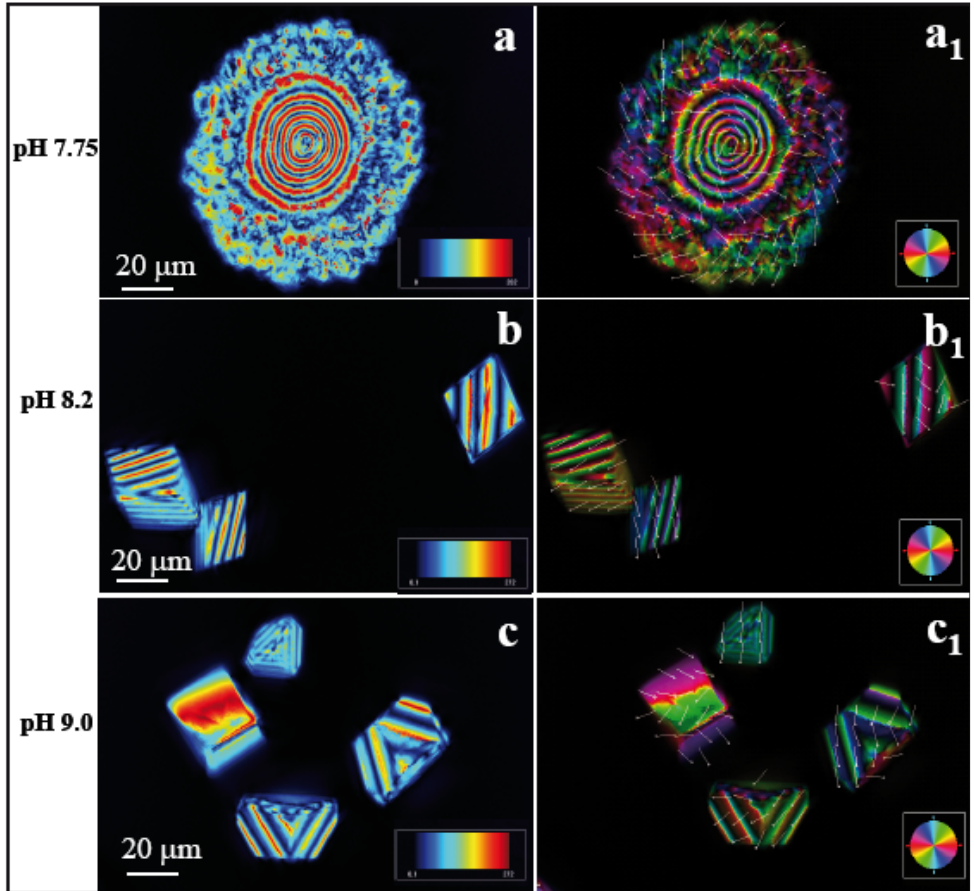
) Peptide AS8 at pH 9.0, c = 6.13 1